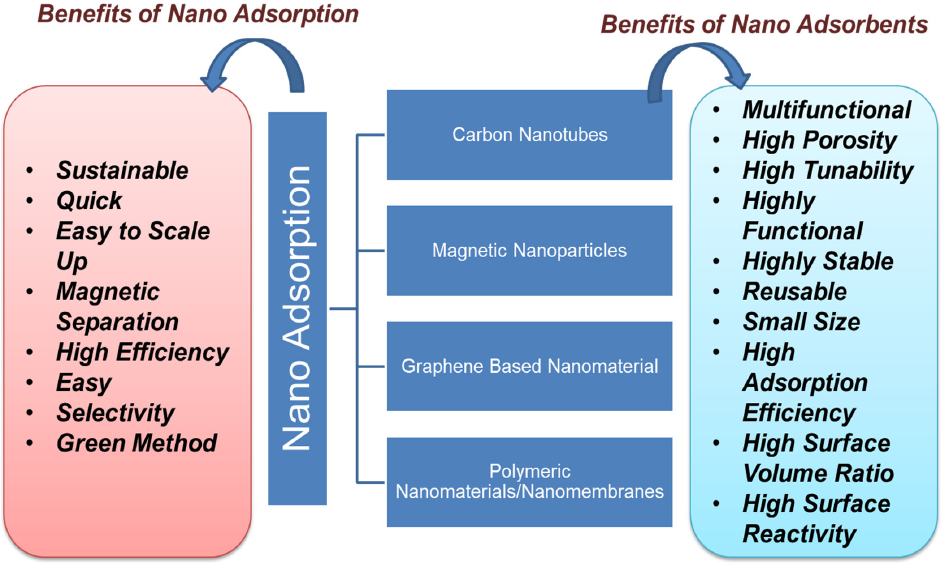
Figure 5. Types and benefits of nanoadsorption.